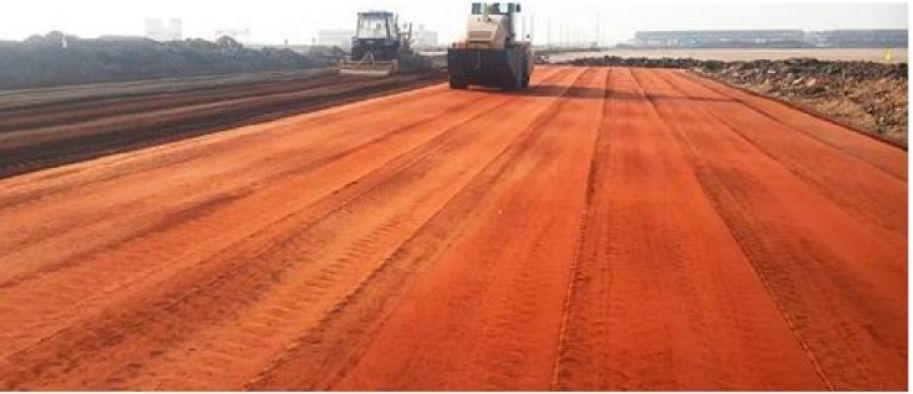
Figure 6. Laying site of RM roadbed lay in somewhere in Shandong province.